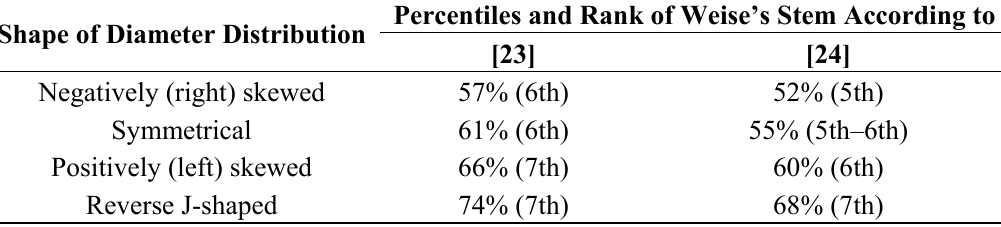
Table 1. Empirical percentiles and ranks of measured stems for QMD estimation. Shape of Diameter Distribution